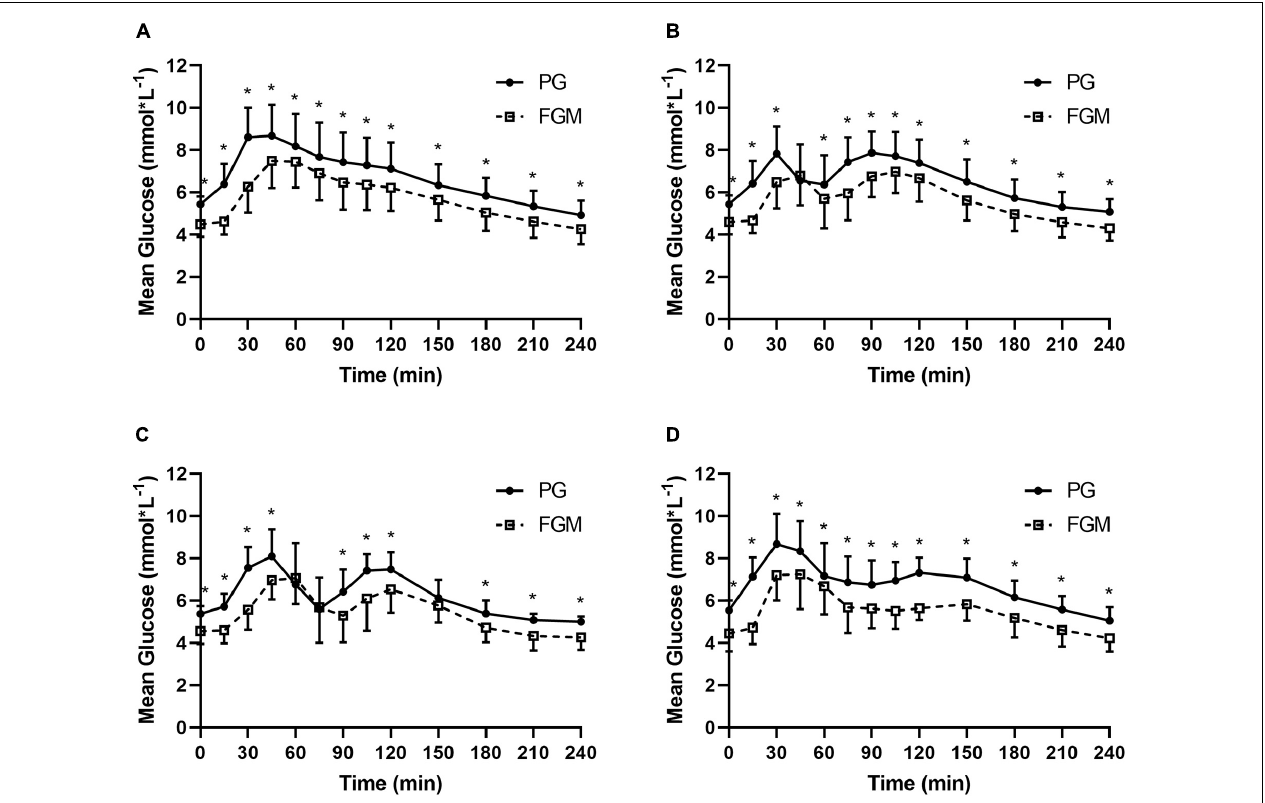
FIGURE 1 | Glucose values from PG (full line) and FGM (dotted line) during SIT (A) , 20iP + CONT (B) , iP + CONT (C) , and 20iP + ACCU (D) . PG, plasma glucose; FGM, interstitial glucose monitored by FGM; SIT, sitting. 20iP + CONT: walking continuously for 30 min initiated 20 min before each participant’s postprandial glucose peak (PPGP); iP + CONT: walking continuously for 30 min initiated at PPGP; and 20iP + ACCU: walking accumulated for 30 min initiated 20 min before PPGP (three bouts of 10 min walking separated by 20 min of rest). Data represent mean ± standard deviation (SD). Paired t -test was used for comparison between FGM and PG. * P < 0.05, PG vs.